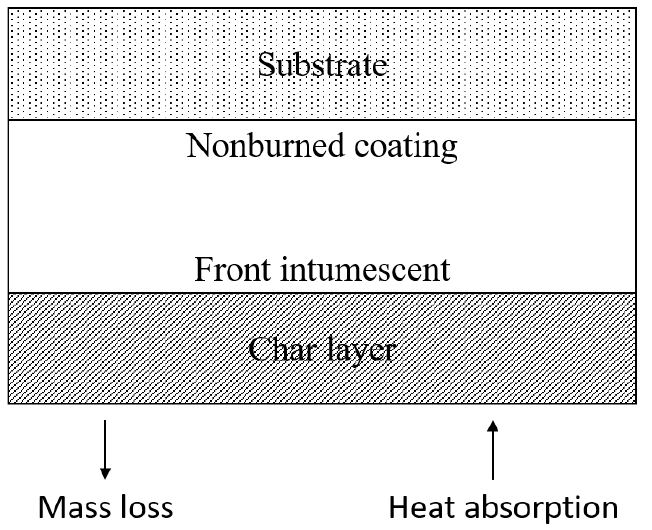
Figure 6. Schematic of multilayer formations during the flame process in intumescent flame retardant coatings.